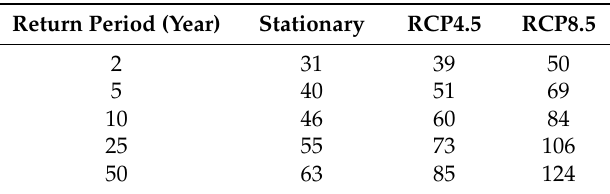
Table 4. Values of Annual Maximum Daily Precipitation (mm) for the return periods and climate scenarios under consideration [59].